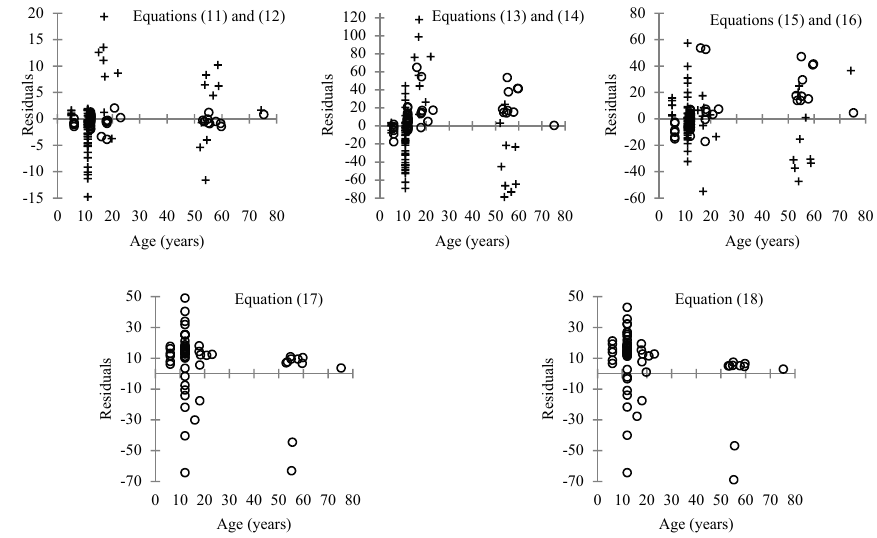
Figure 3. Residual plots of equations adjusted for state variables: average diameter at breast height (Equations (5)–(8)); basal area (Equations (9)–(12)); volume (Equations (13)–(16)), and; mortality (Equations (17) and (18)).